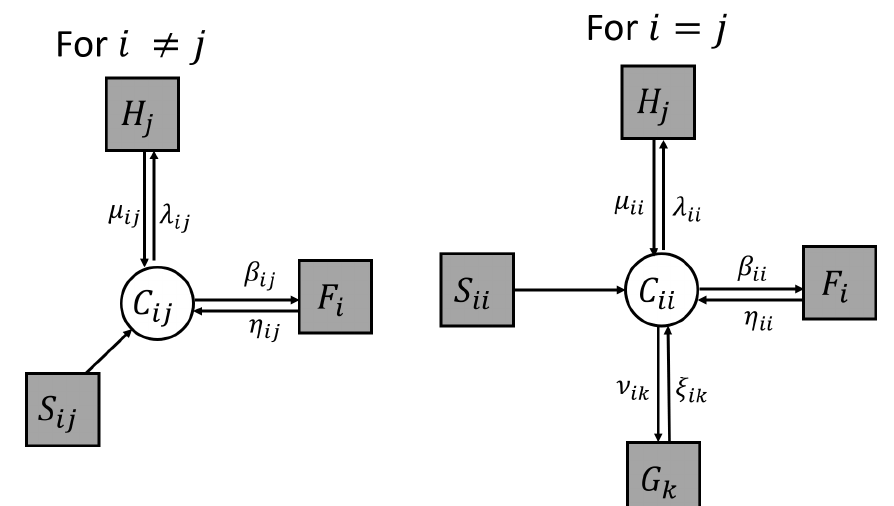
Figure 3. Message passing of each variable. The figure on the left shows the non-diagonal variable and that on the right shows the diagonal